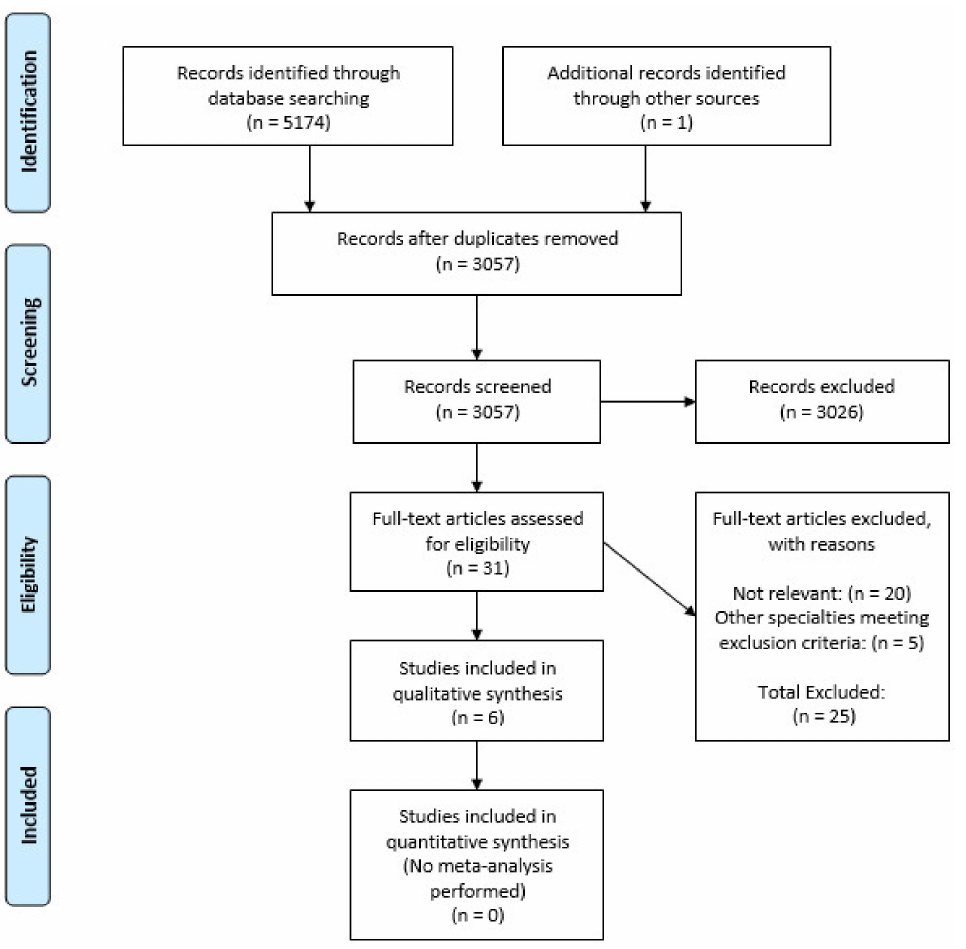
Figure 1. PRISMA 2009 flow